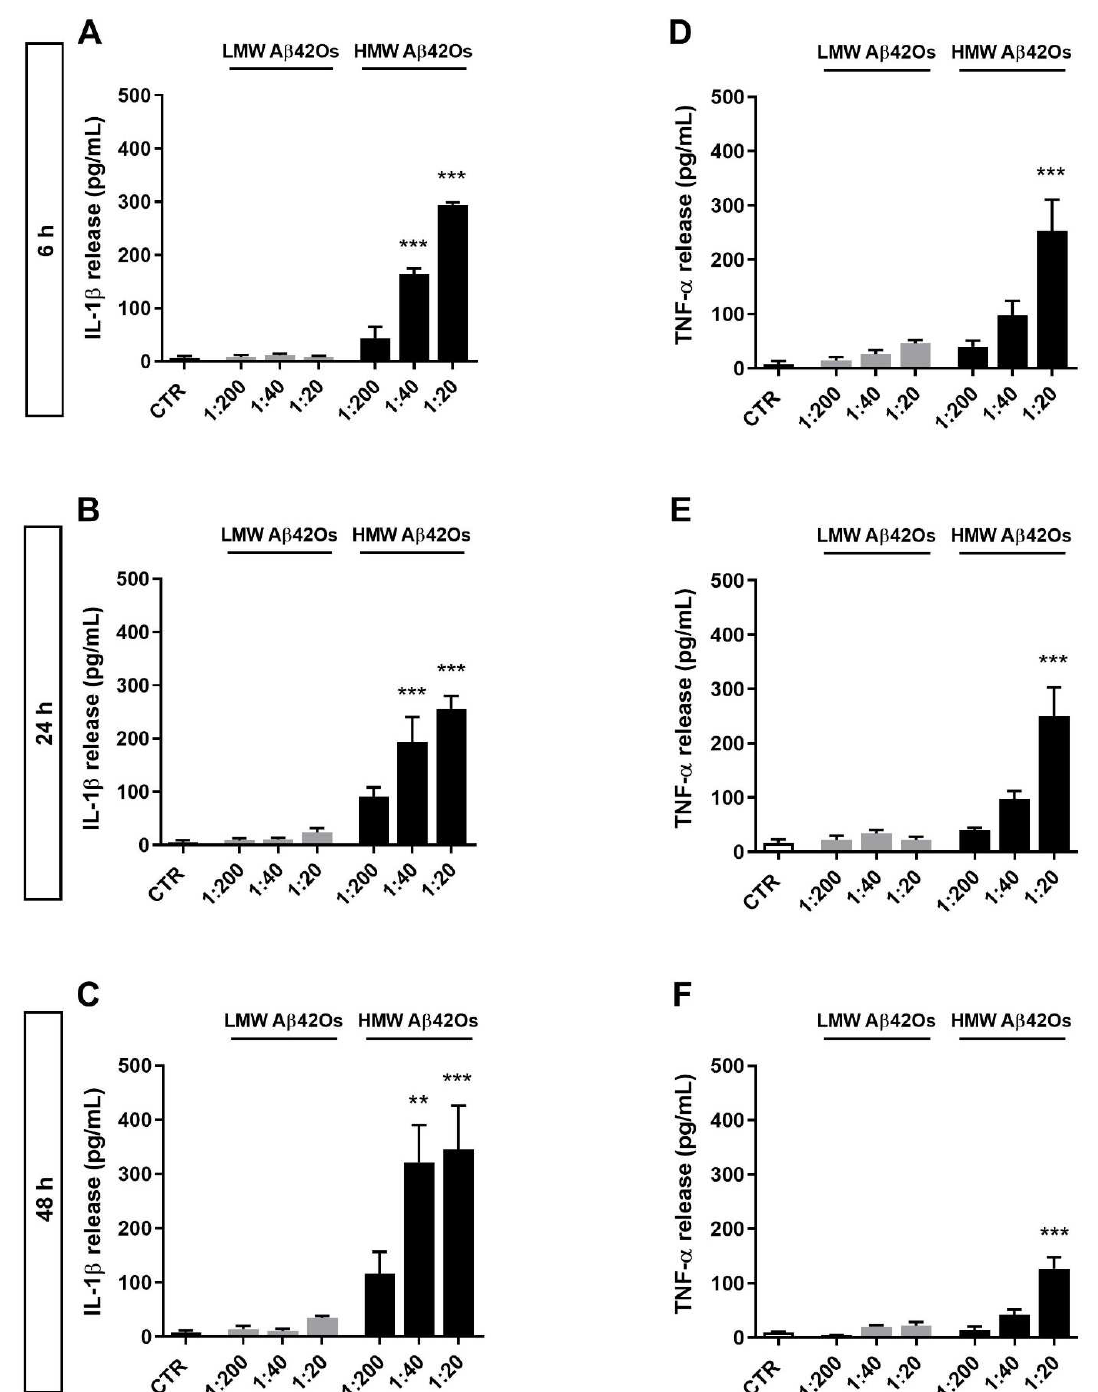
Figure 3. Effect of A β 42 oligomers on cytokine release from cortical microglia. Microglia were cultured overnight in medium containing 10% serum, which was replaced with serum-free medium before treatment with vehicle, or a serial dilution of LMW and HMW A β 42Os for 6, 24, or 48 h. Supernatants were collected and analyzed for IL-1 β ( A – C ) and TNF- α ( D – F ) release by ELISA. Data are means ± SEM (n = 3 in triplicate). ** p < 0.01, and *** p < 0.001 versus control cells. Two-way ANOVA, followed by Tukey’s multiple comparison test.